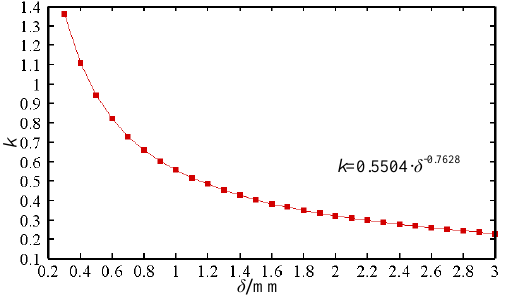
Figure 2. Relationship curve between the air-gap and k .